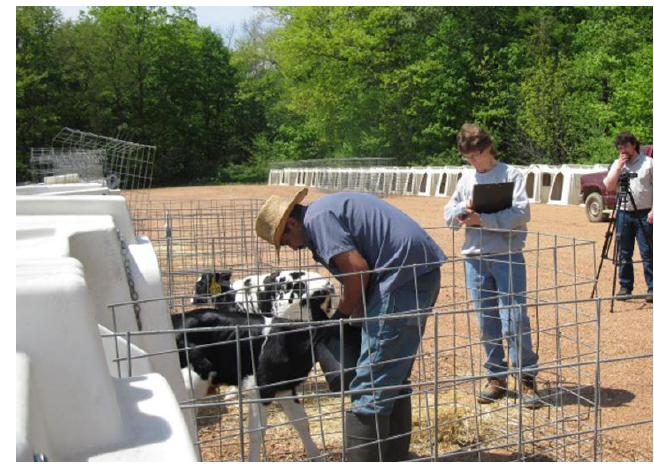
Figure 1. Occupational therapist collecting field data .